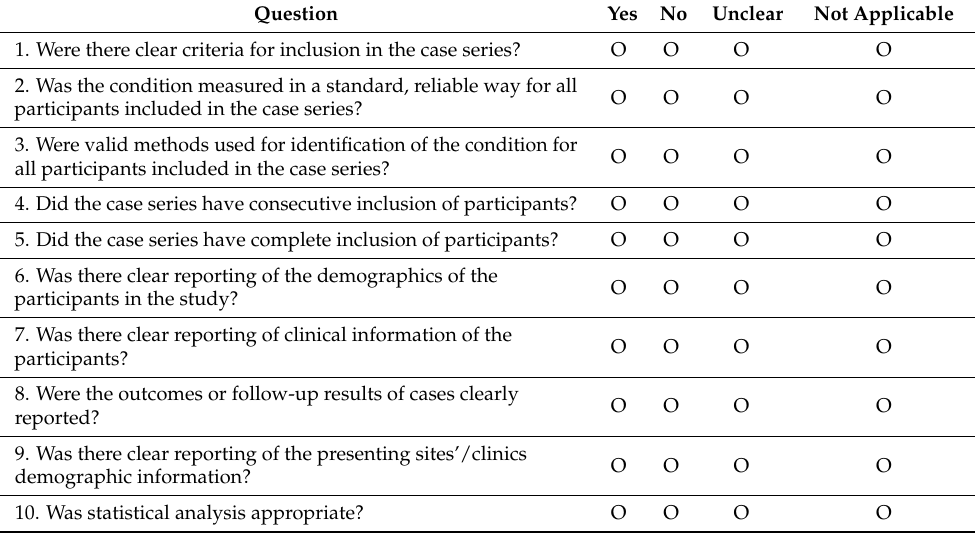
Table 1. Risk-of-bias assessment—Items